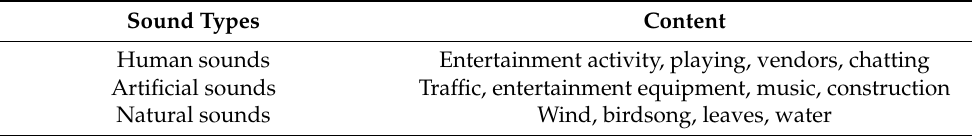
Table 1. Composition of the Century Park soundscapes.